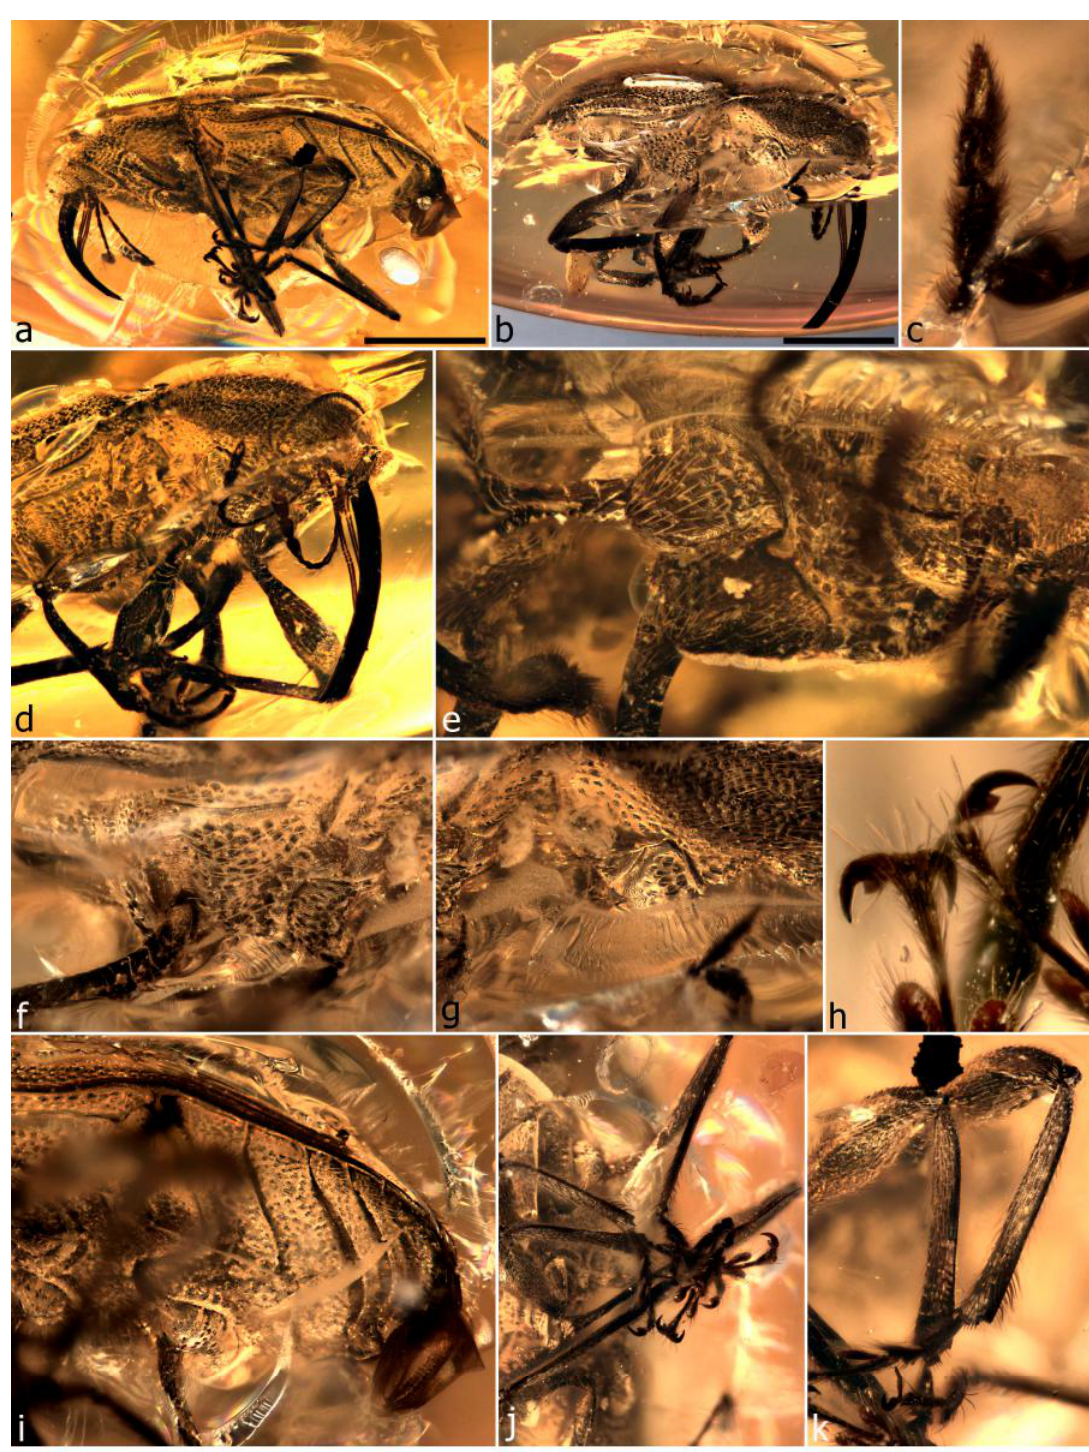
Figure 60. Mekorhamphus gracilipes sp. n., holotype. Habitus, left ventrolateral ( a ); habitus, right lateral ( b ); detail of antennal club ( c ); head and thorax, oblique frontal ( d ); prothorax and coxae, ventrolateral ( e ); metathorax, lateral ( f ); prothorax showing notosternal suture ( g ); tarsal claws ( h ); ventrites, ventrolateral ( i ); legs ( j ); meso- and metatibiae, outer sides ( k ). Scale bars: 1.0 mm (a,b).